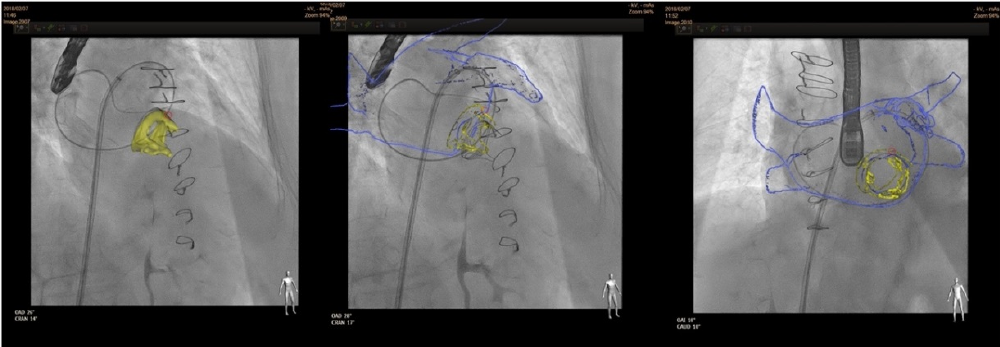
Figure 5. CT–fluoroscopy fusion for mitral PVL closure .